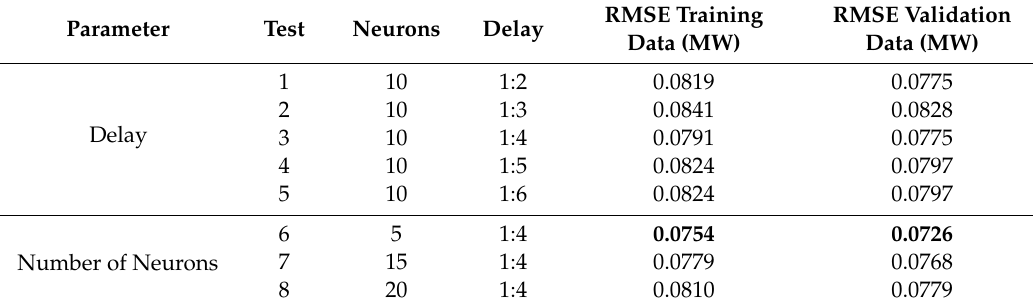
Table 8. Structure design test for option